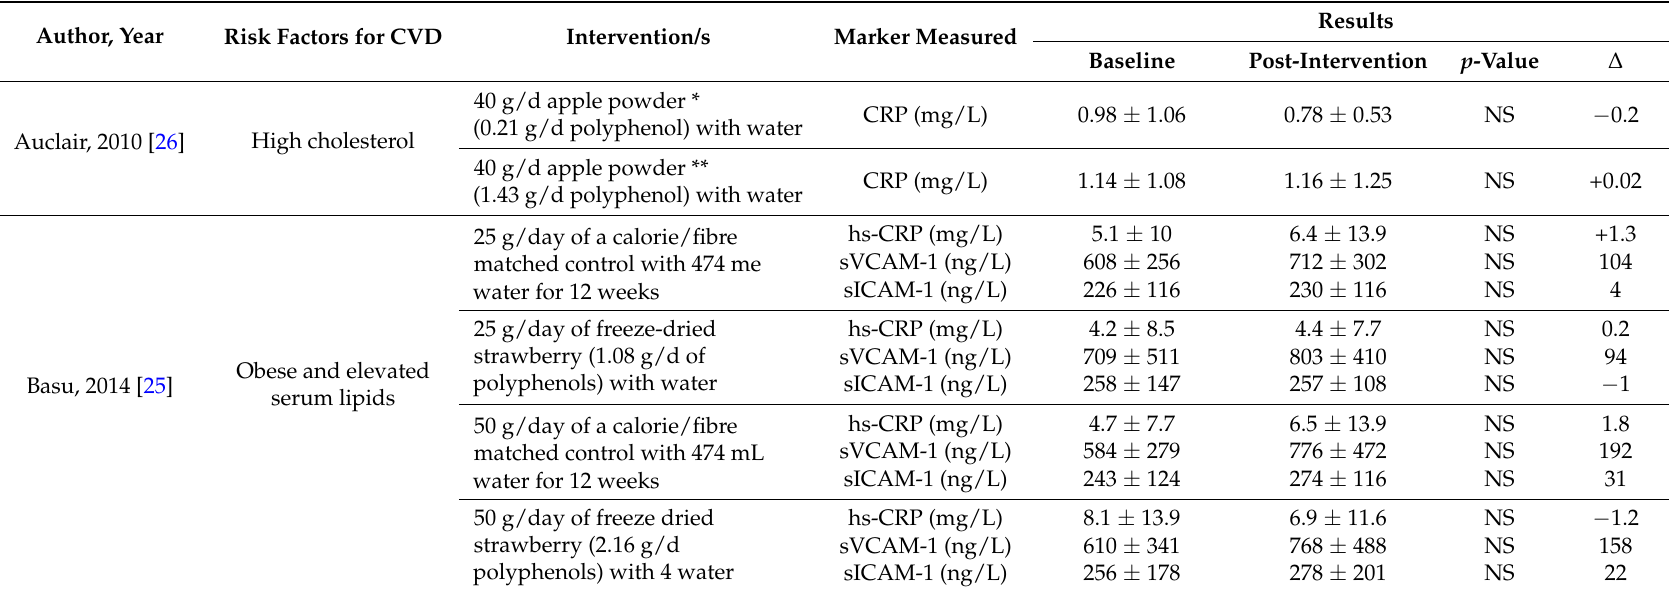
Table 6. Effect of freeze-dried fruit polyphenols on inflammatory markers at baseline and